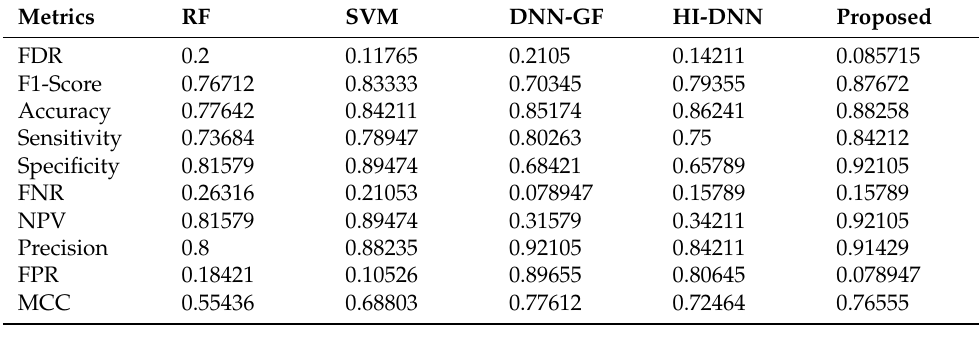
Table 4. Classification results without segmentation.